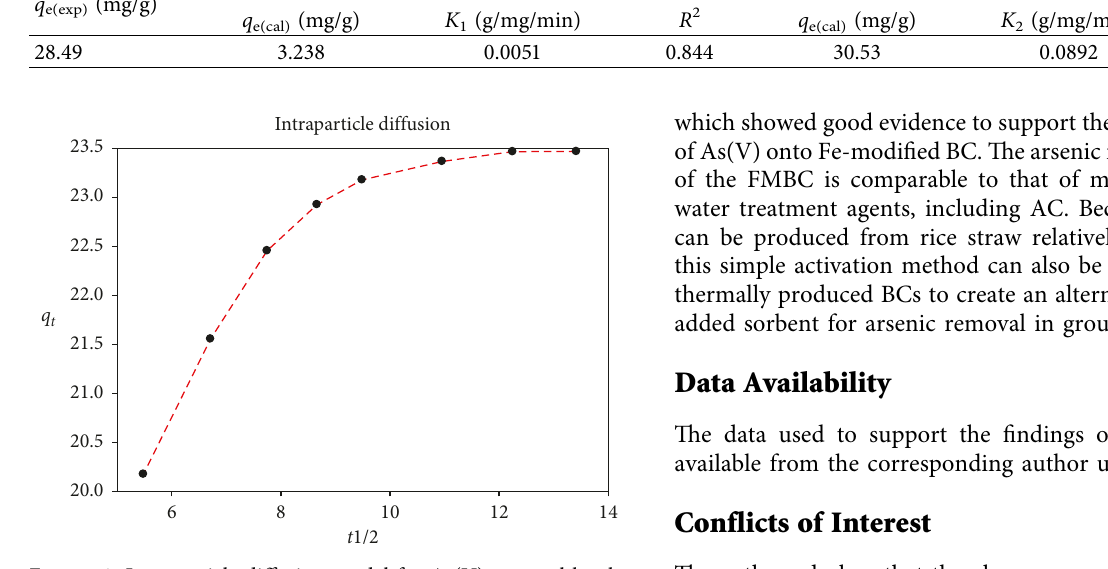
Figure 9: Intraparticle diffusion model for As(V) removal by the